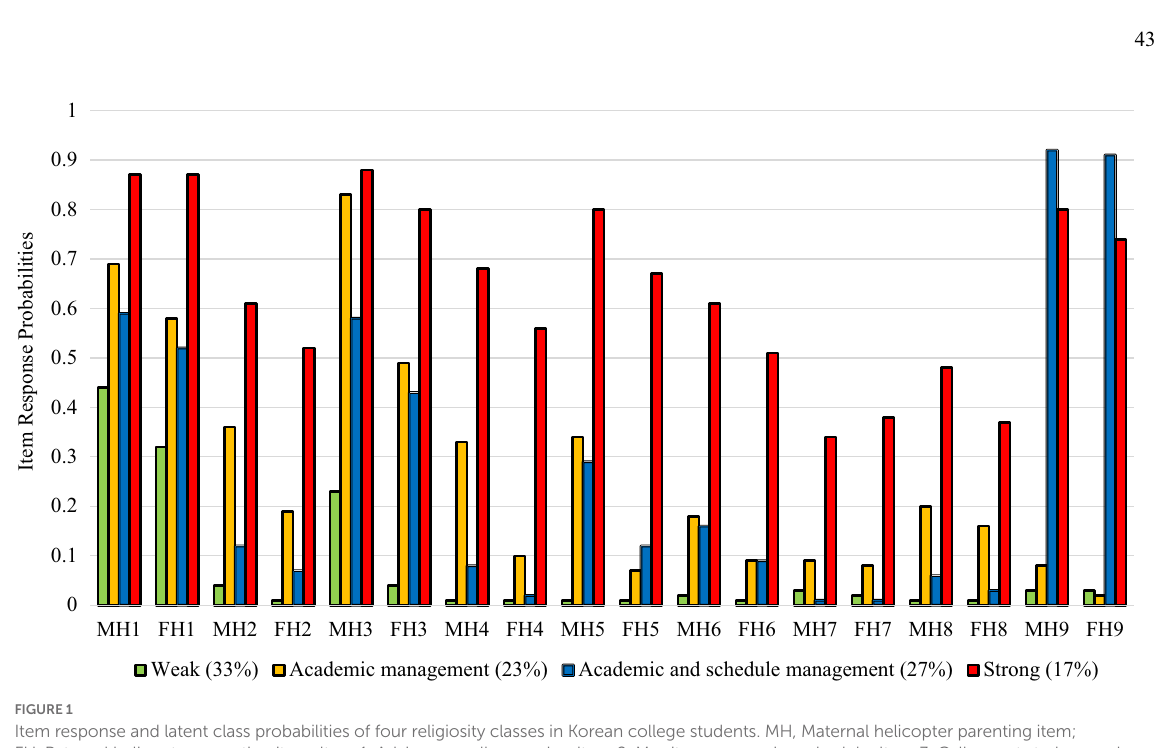
FIGURE 1 Item response and latent class probabilities of four religiosity classes in Korean college students. MH, Maternal helicopter parenting item; FH, Paternal helicopter parenting item. Item 1, Advise my college major; Item 2, Monitor my exercise schedule; Item 3, Call parents to know where I am; Item 4, Monitor my diet; Item 5, Monitor who I spent time with; Item 6, Call me to track my schoolwork; Item 7, Call professor about a low grade; Item 8, Intervene my roommate issue; Item 9, Have a curfew every